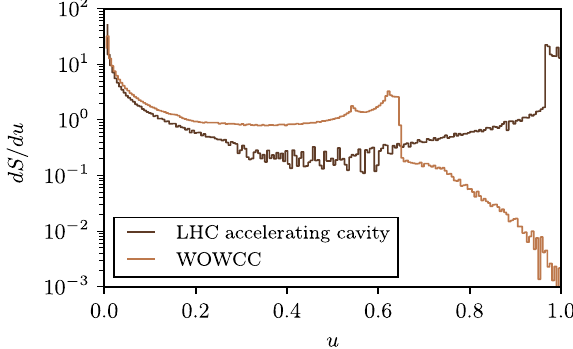
FIG. 5. Surface density function versus surface magnetic field u ¼ B=B pk of the fundamental